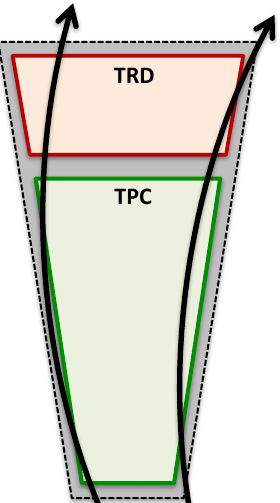
Figure 11. Momentum resolution for the tracks with ( right ) and without ( left ) TRD in track refit as a function of the relative position (in azimuth) inside a TPC sector (see Figure 12) for tracks with p T > 5 GeV/ c .